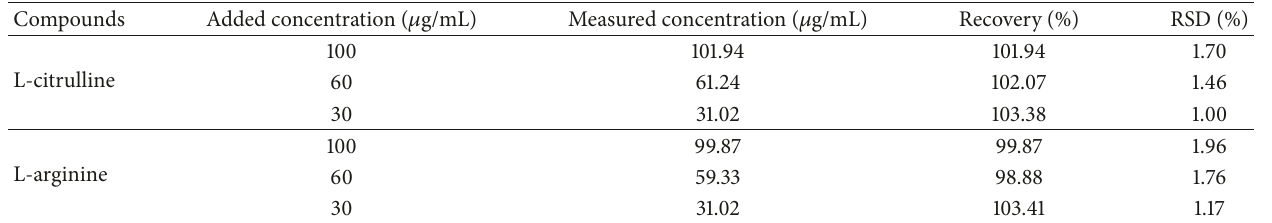
Table 3: Recovery of L-citrulline and L-arginine standard reported from isocratic RP-HPLC method. Compounds